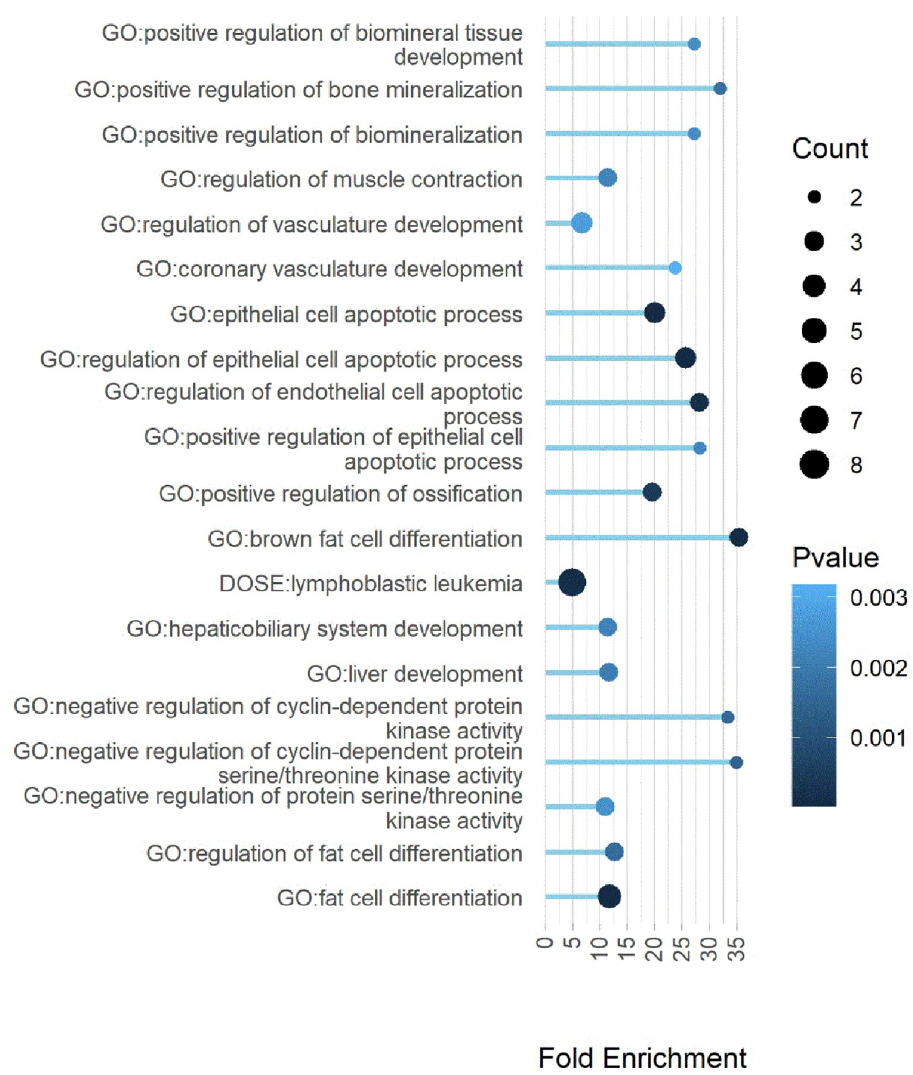
Fig 5. Pathways with significant enrichment in LIFE-Adult and LIFE-Heart (FDR < 5%). If two pathways are enriched due to the identical set of replicated genes, only the pathway with the higher enrichment (i.e. higher Odds ratio) is shown here. All significantly enriched pathways are reported in S5 Table. Differentially expressed genes per pathway are shown in S6